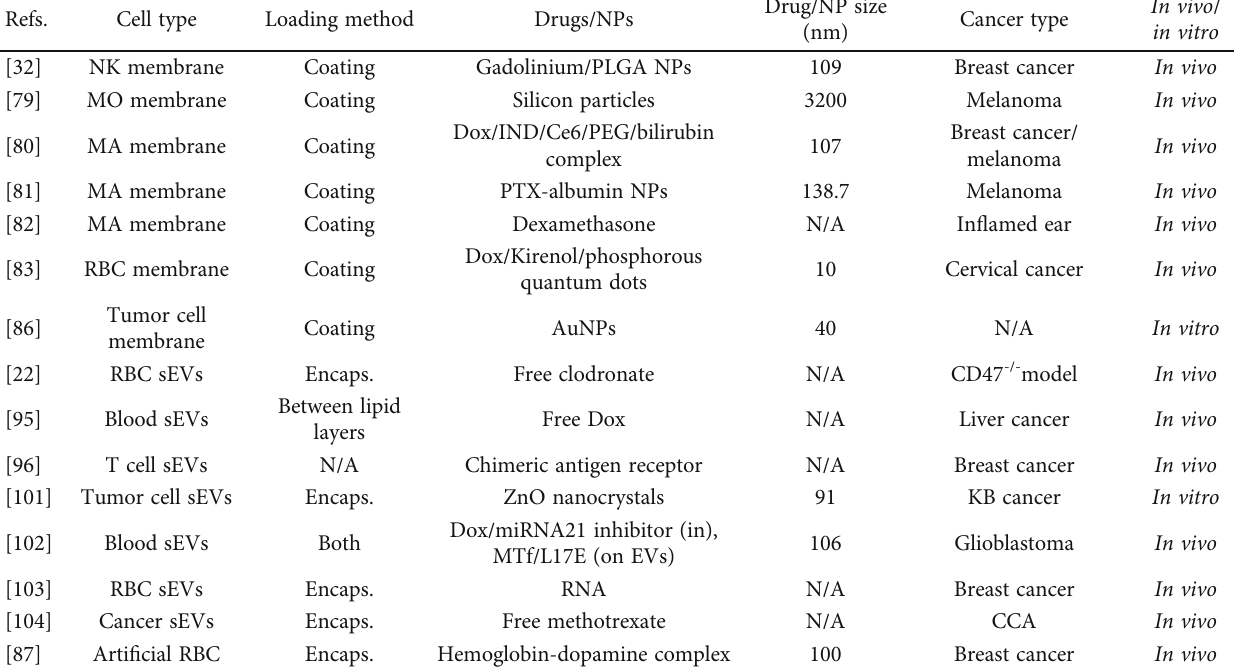
Table 4: Di ff erent cell derivatives loaded with varied cargos for cancer diagnosis and therapy.